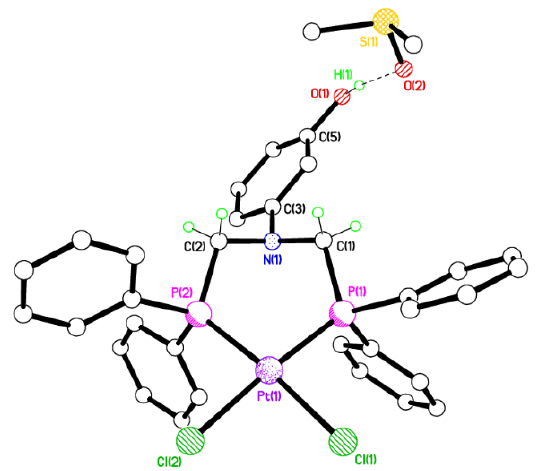
Figure 7. Crystal structure of 6 ∙ (CH 3 ) 2 SO showing the hydroxyl group H-bonding to the (CH 3 ) 2 SO molecule of crystallisation. Most H-atoms omitted for clarity.